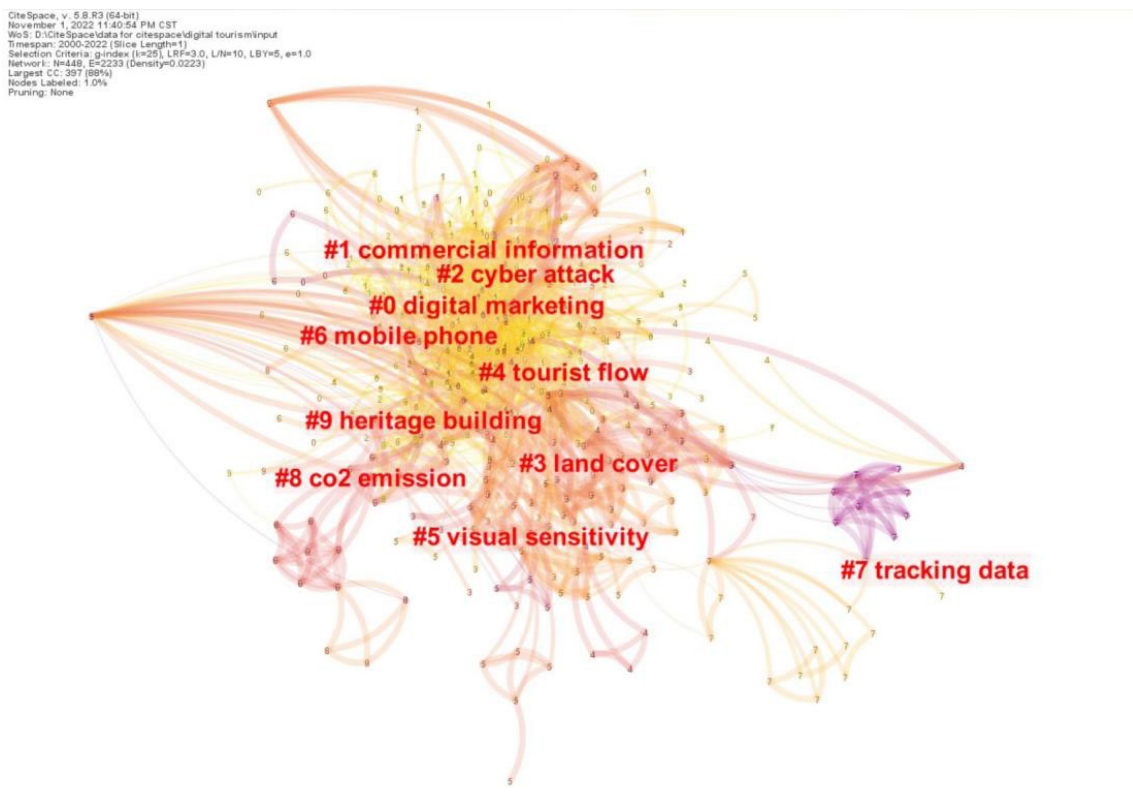
Figure 6. Knowledge map of keywords cluster